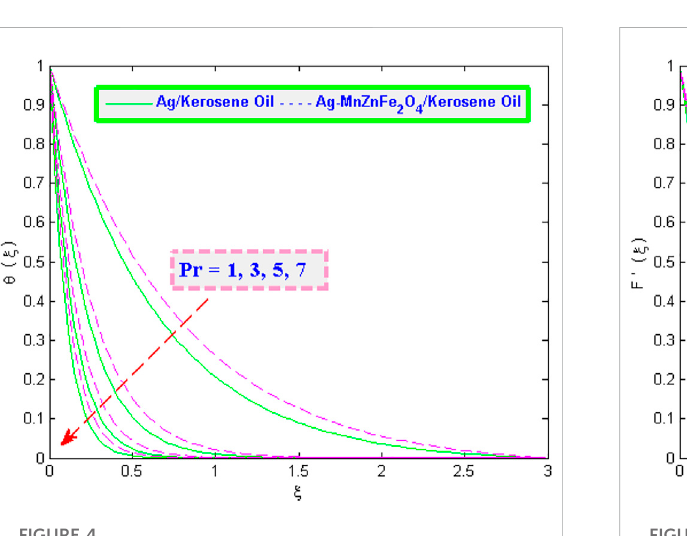
FIGURE 6 Variation in velocity with ϕ 2